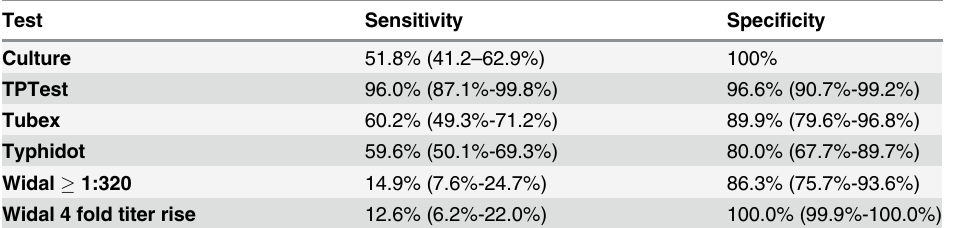
Table 3. Estimated sensitivity and specificity of six diagnostic tests for enteric fever in 92 febrile patients (95% confidence intervals shown in parenthesis), under a Bayesian latent class modeling